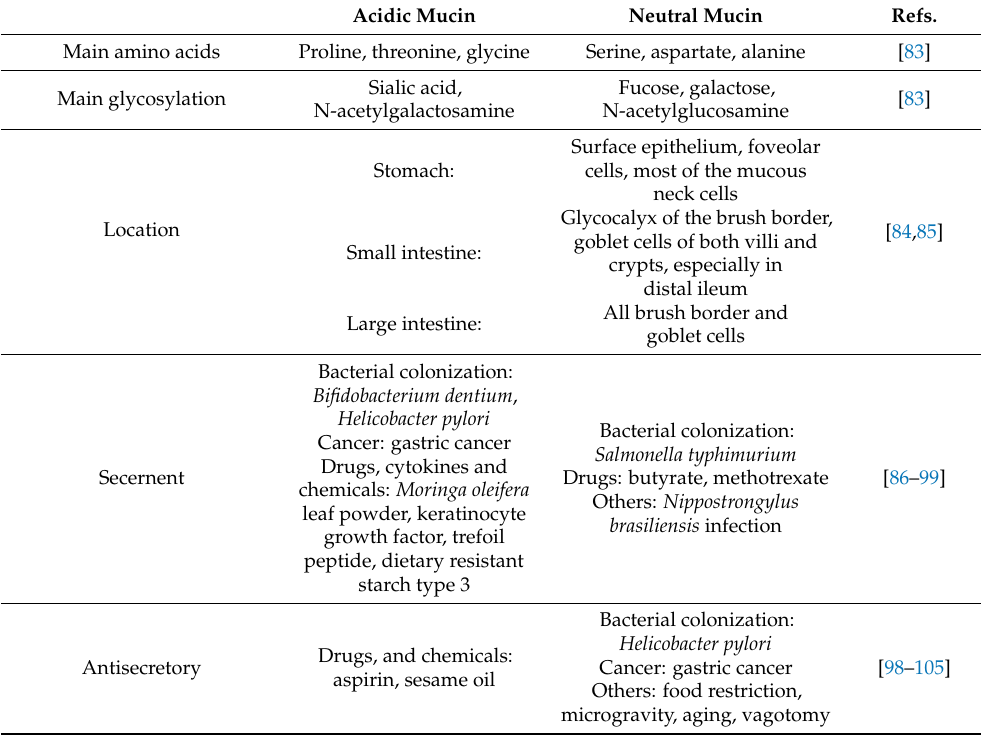
Table 2. Comparison of the general characteristics of acidic and neutral mucin. Acidic